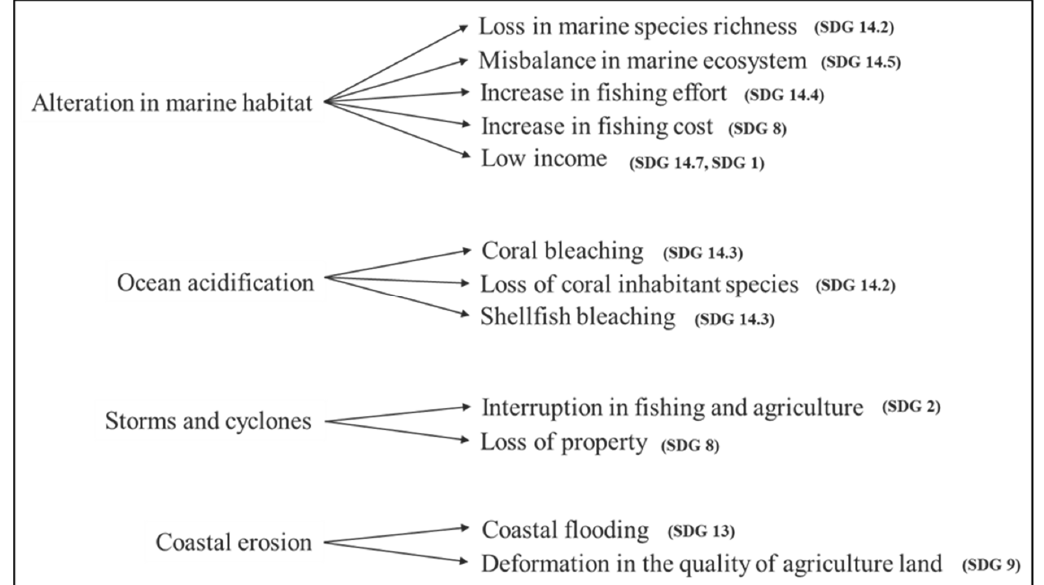
Figure 14. Potential effects of increased SST in the GoM.